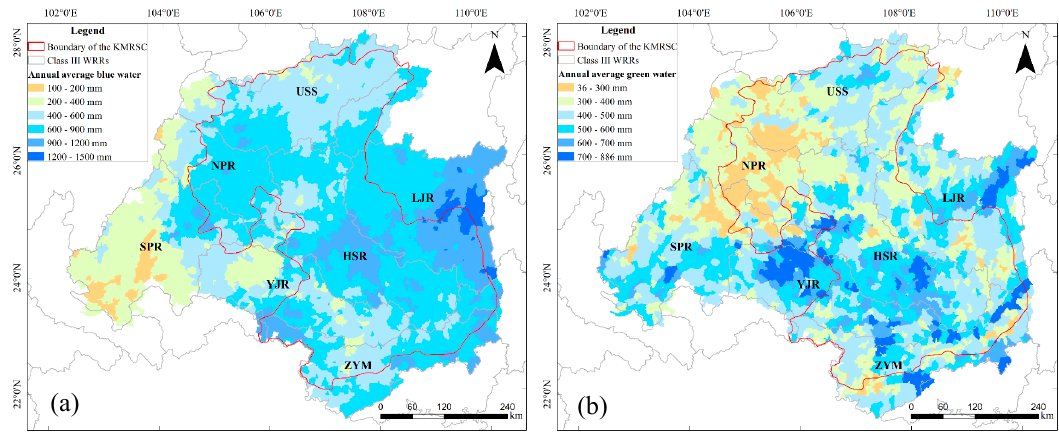
evapotranspiration, respectively.